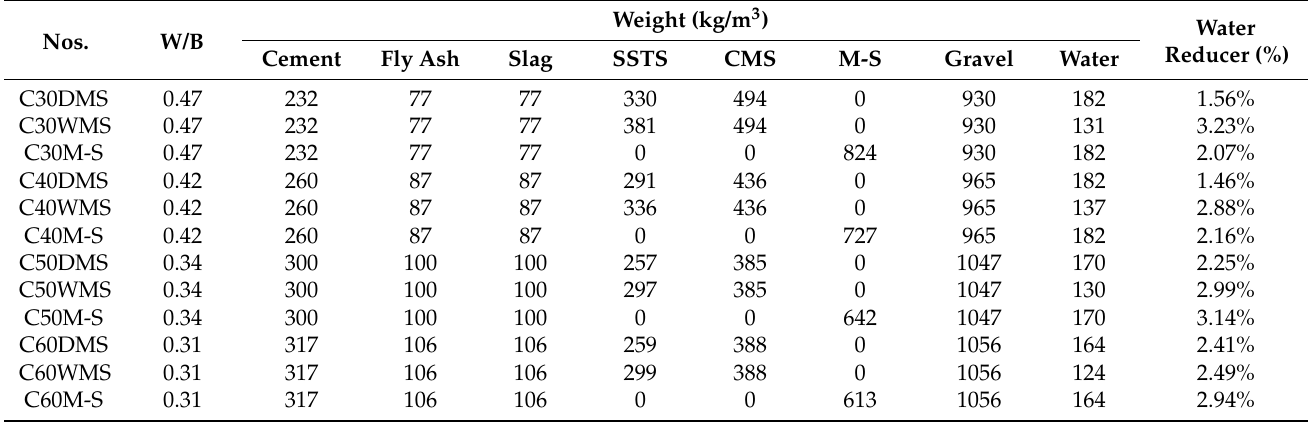
Table 5. Mix proportion of